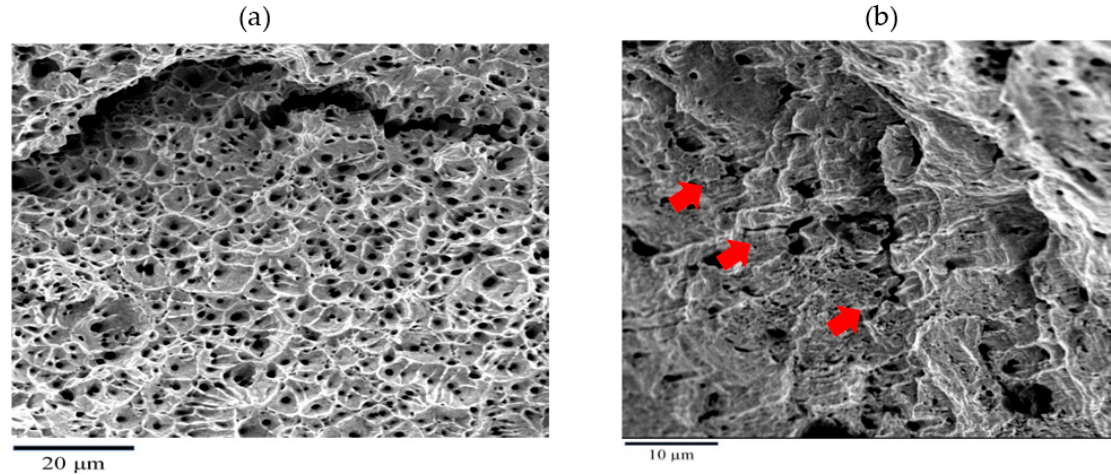
Figure 3. SEM fractography of 316 stainless steel samples tested in SW at: ( a ) 25 °C and ( b ) 60 °C. Arrows shows the features of SCC that were located in the areas adjacent to the sample edge.